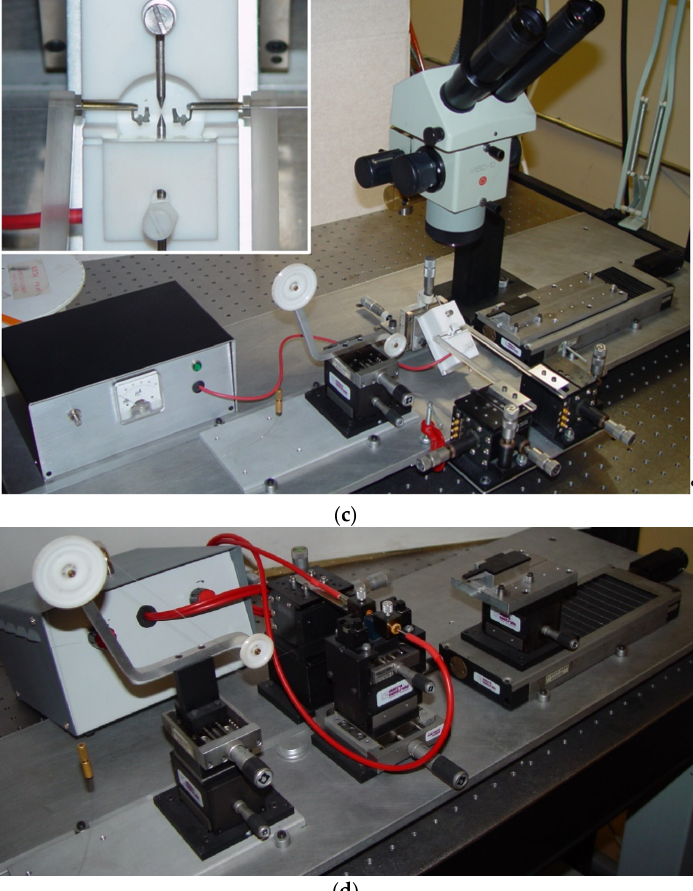
Figure 2. Evolution of the experimental setup for LPFGs fabrication. ( a ) Setup by O. Okhotnikov comprising three independent blocks: the BICC fusion splicer, a motorized translation stage, and a pulley. Inset: v-grooves and electrodes of the fusion splicer; ( b ) Improvement of the alignment of the previous setup and computer-controlled arc discharge (the arc parameters had to be previously defined); ( c ) Setup by F. M. Araújo comprising the homemade high-voltage power supply (unstable), the electrodes support, and the fiber alignment block. Inset: The central block allowing for the positioning of the fiber in-between the electrodes (poor alignment confirmed by using the microscope); ( d ) New setup comprising another high-voltage power supply (unstable) and mechanical stability achieved by the use of three independent blocks: the motorized translational stage, the pulley and the central block with two independent v-grooves set, and the electrodes support. Adapted from [102].